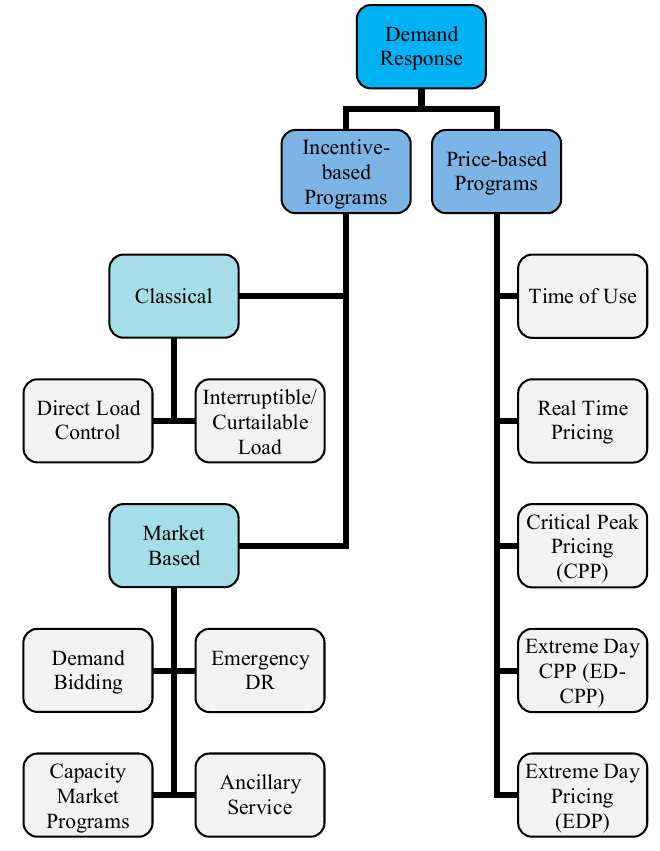
Figure 2. Categories of demand response programs [38].